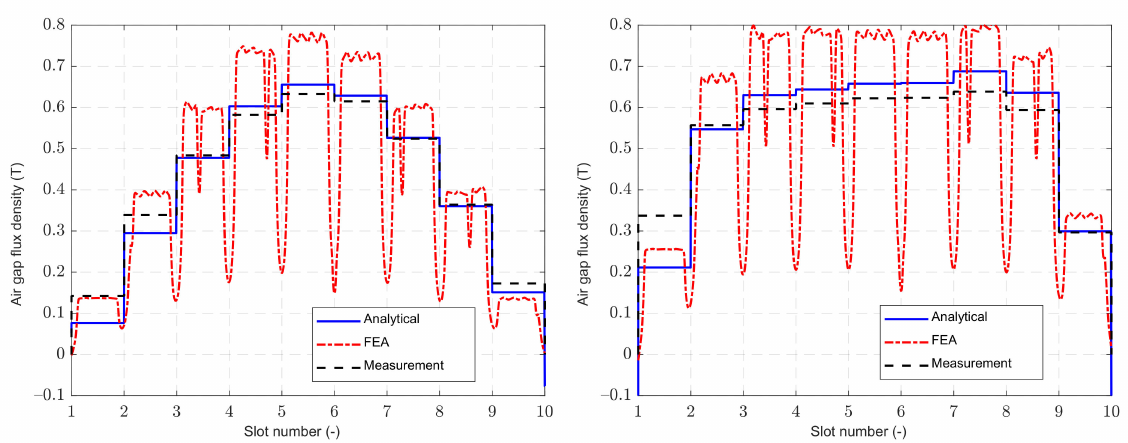
Figure 11. Air gap magnetic flux density excited by single and higher order harmonic components injection obtained by analytical calculation, FEA, and